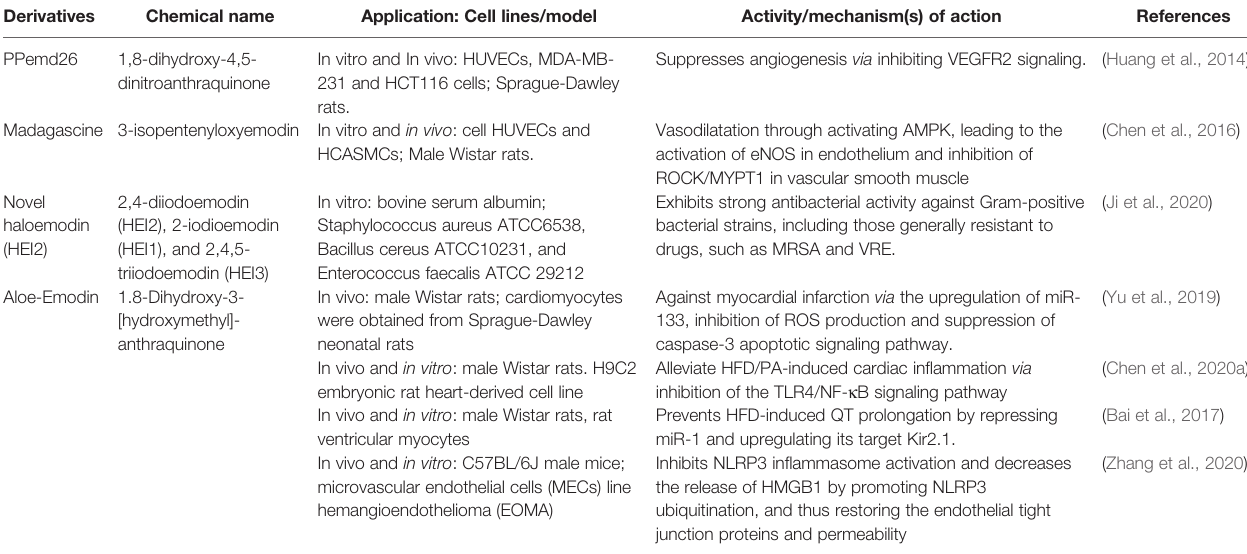
TABLE 3 | Anti-cardiovascular effects of emodin